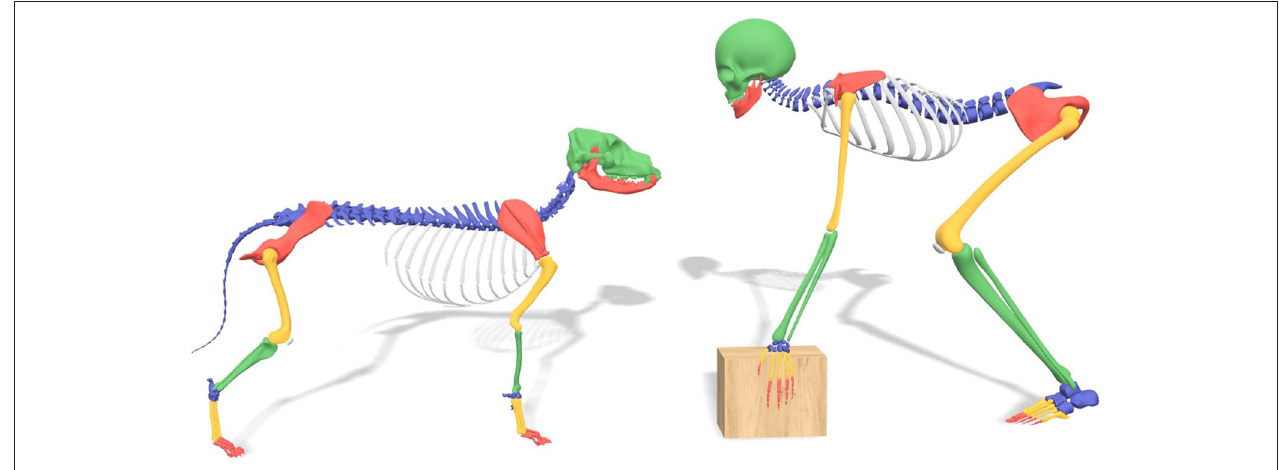
FIGURE 1 | Comparison skeletal structure between dog and